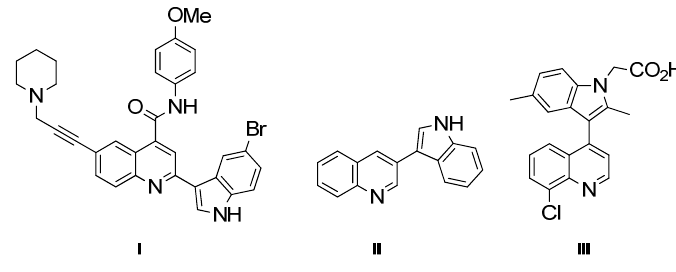
Figure 1. Bioactive indolylquinolines derivatives.